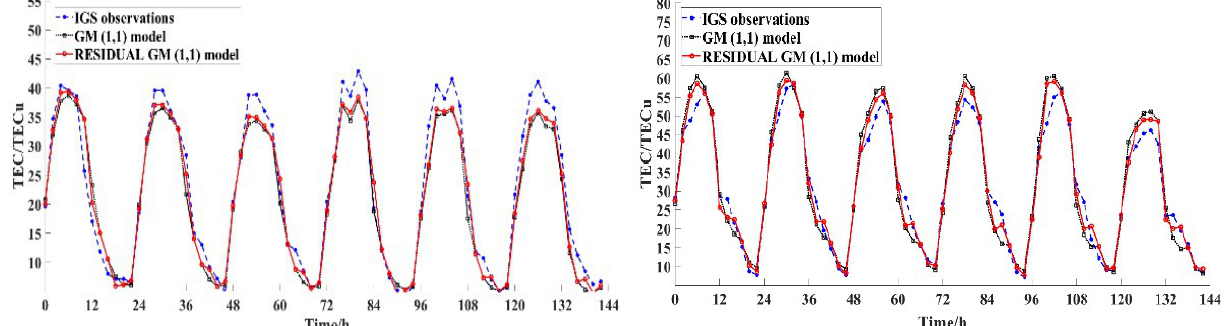
Figure 2. TEC forecast for 6 days in summer at low latitudes